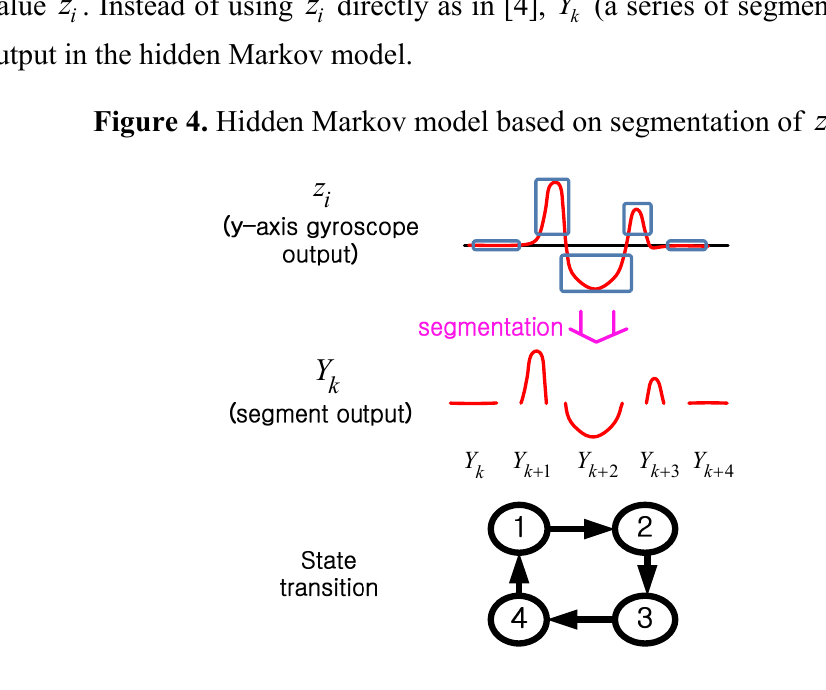
Figure 4. Hidden Markov model based on segmentation of